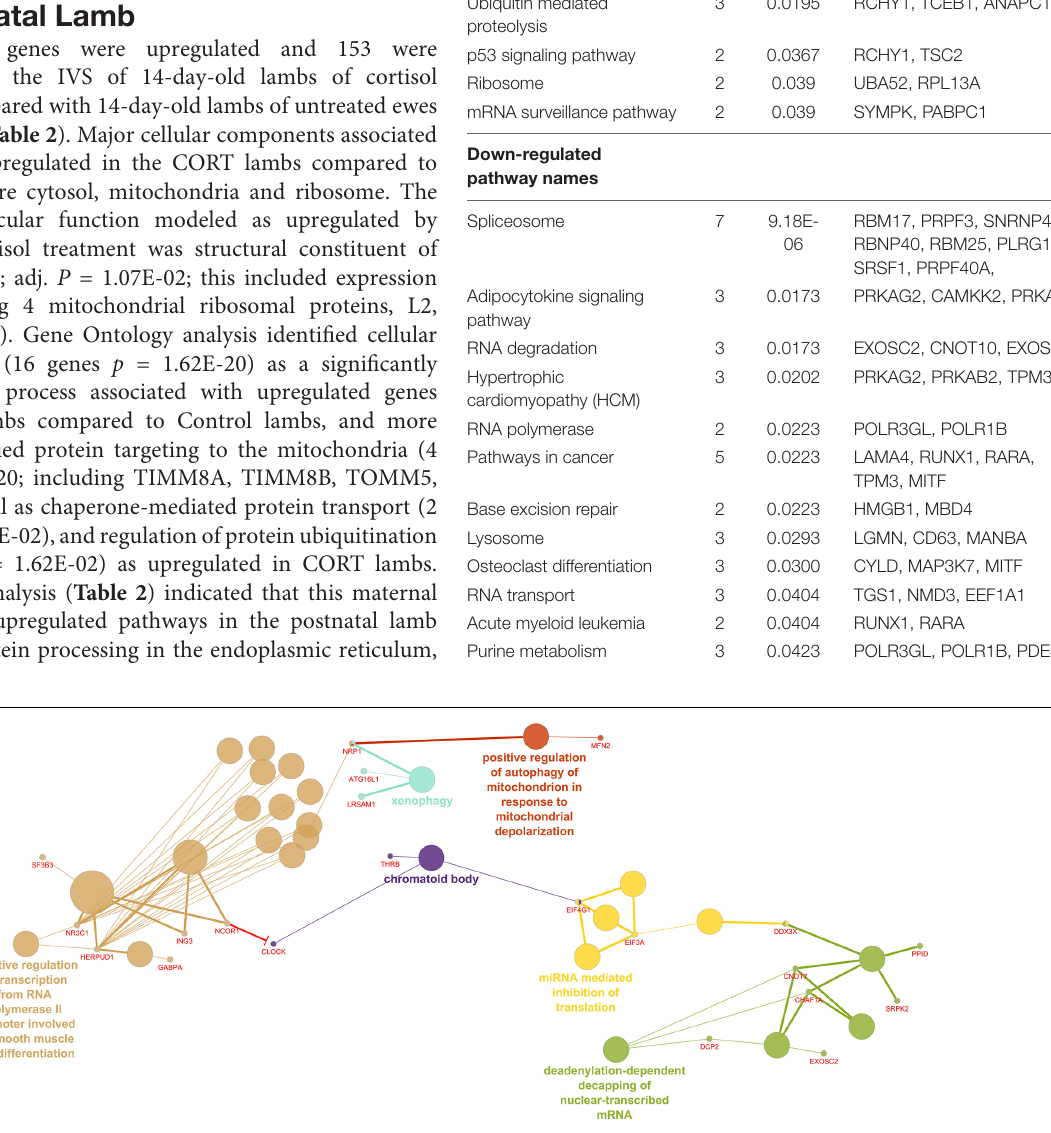
Frontiers in Physiology |